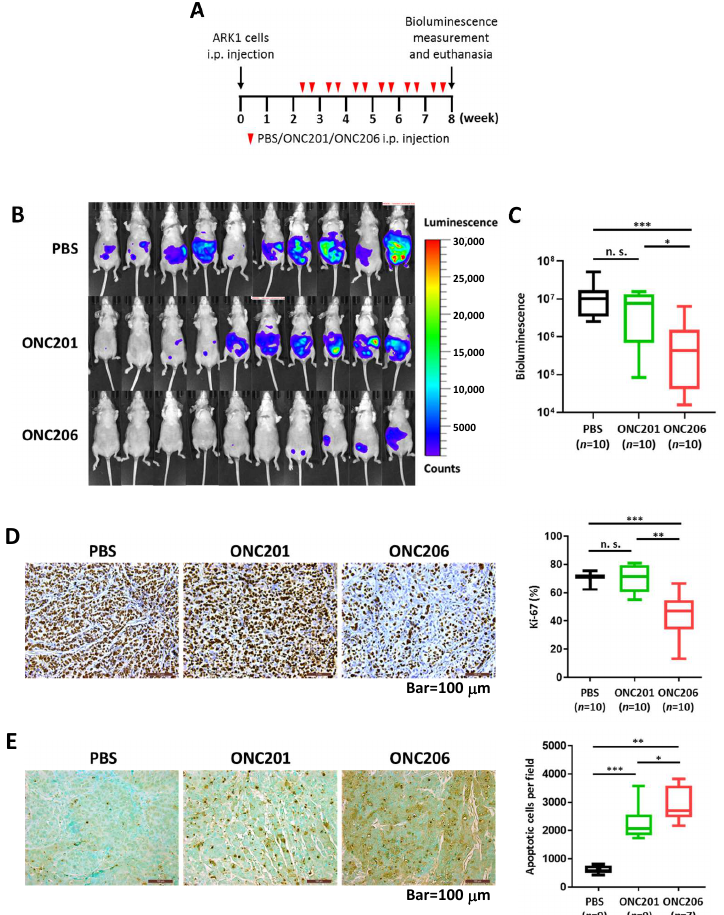
Figure 2. E ff ect of ONC206 on uterine tumor growth and apoptosis in vivo. ( A ) Schema shows the use of an in vivo model to evaluate the e ff ect of ONC206 on uterine tumor growth. i.p., intraperitoneal; PBS, phosphate-bu ff ered saline. ( B ) Images show lower bioluminescence signals in ARK1 cell-bearing nude mice treated with ONC201 ( n = 10) or ONC206 ( n = 10) than in untreated PBS controls ( n = 10). ( C ) Box plot shows a significantly lower bioluminescence from ARK1 cell-bearing nude mice treated with ONC206 ( n = 10) than those treated with ONC201 ( n = 10; p < 0.05, Mann–Whitney U test) or untreated PBS controls ( n = 10; p < 0.001, Mann–Whitney U test). ( D , E ) Representative microscopic images of para ffi nized sections of tumor tissues collected from ARK1 cell-bearing nude mice 6 weeks after treatment with ONC201 or ONC206, showing significantly ( D ) lower Ki-67 expression and ( E ) higher apoptosis in the ONC206 treatment group compared with the ONC201 treatment group or untreated controls. Bar = 100 µ m. Quantification of cell staining positively for Ki-67 or apoptotic cells for each group is shown in the box plot. *** p < 0.001, ** p < 0.01, * p < 0.05, n. s. = not significant ( p > 0.05), Mann-Whitney U